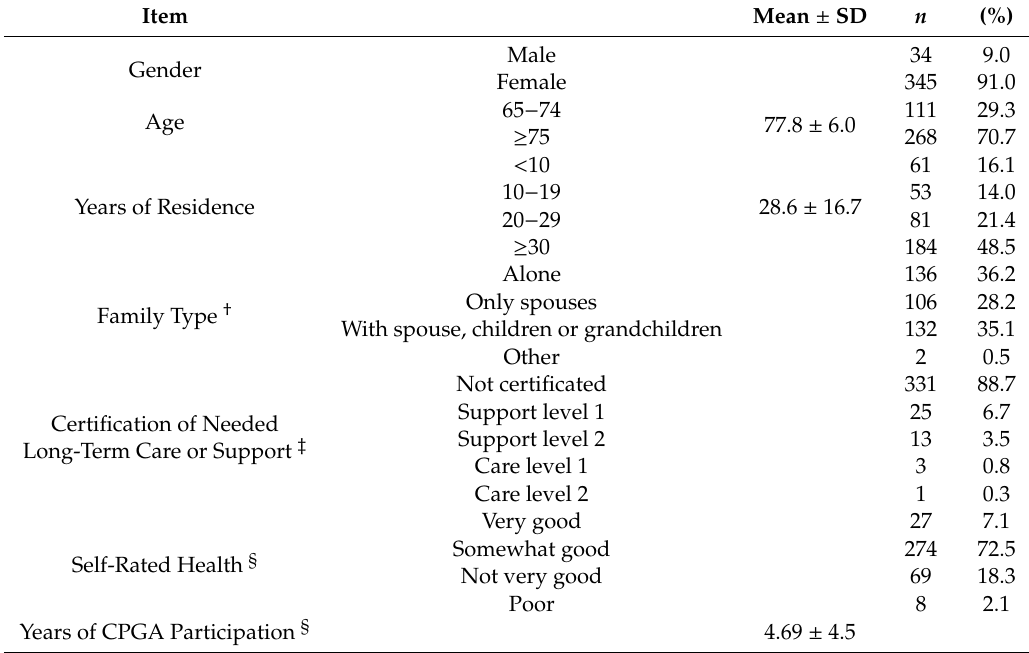
Table 1. Individual factors of subjects ( n =